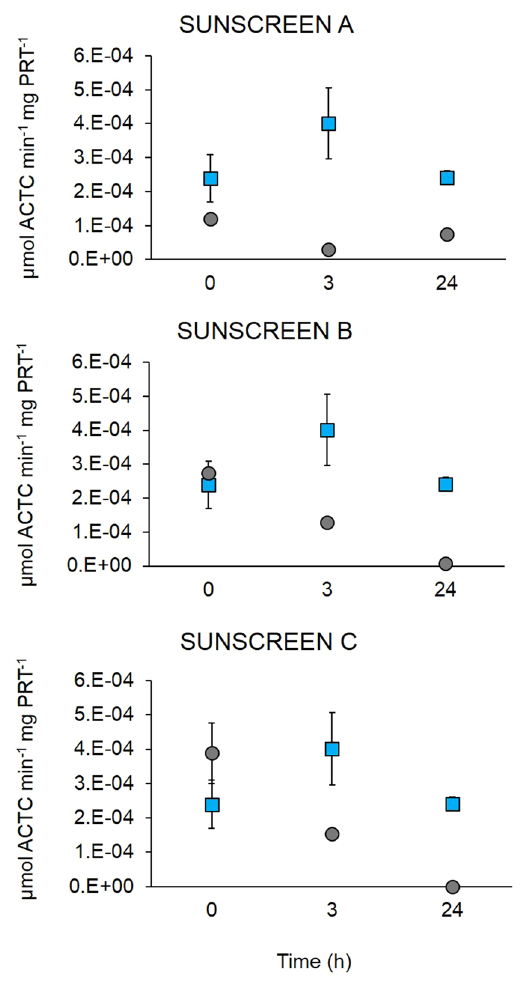
Figure 5. Effects of Sunscreens ( A , B and C ), at the concentration of 50 µ L L − 1 , on AChE activity of larvae of P. lividus compared to the control (square symbols). Error bars represent standard deviation (n =